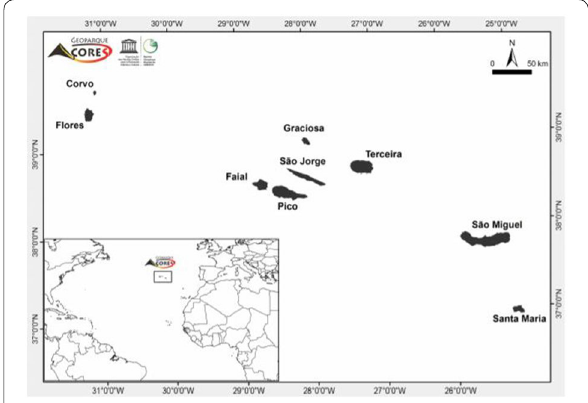
Fig. 1 Geographical location of Azores